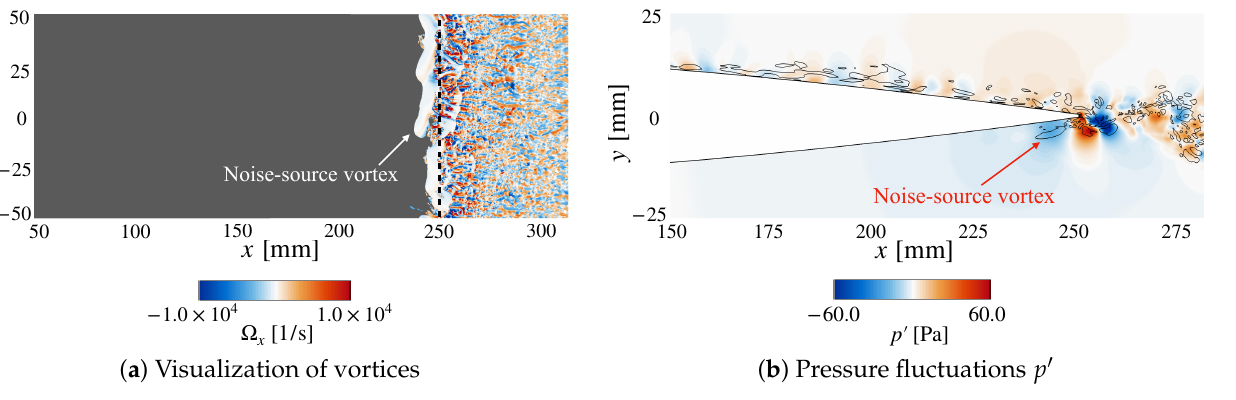
Figure 14. A visualization of the instantaneous flow field just before the energy deposition at t = − 3.44 ms. The figures show ( a ) vortices by iso-surfaces of Q -criterion ( Q = 2 × 10 6 s − 2 ) and ( b ) pressure fluctuations p (cid:48) , respectively. The iso-surfaces are colored by x -wise vorticity Ω x . The black-dashed line in ( a ) indicates the trailing edge of the airfoil. The pressure field also shows contour lines of Q = 2 × 10 6 s − 2